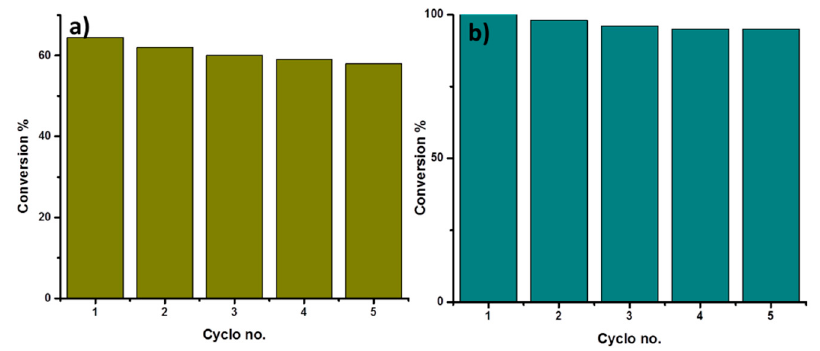
Figure 5. Reusability of the catalyst in conversion of the ( a ) isoeugenol and ( b ) vanillyl alcohol to vanillin under the optimal reaction conditions.